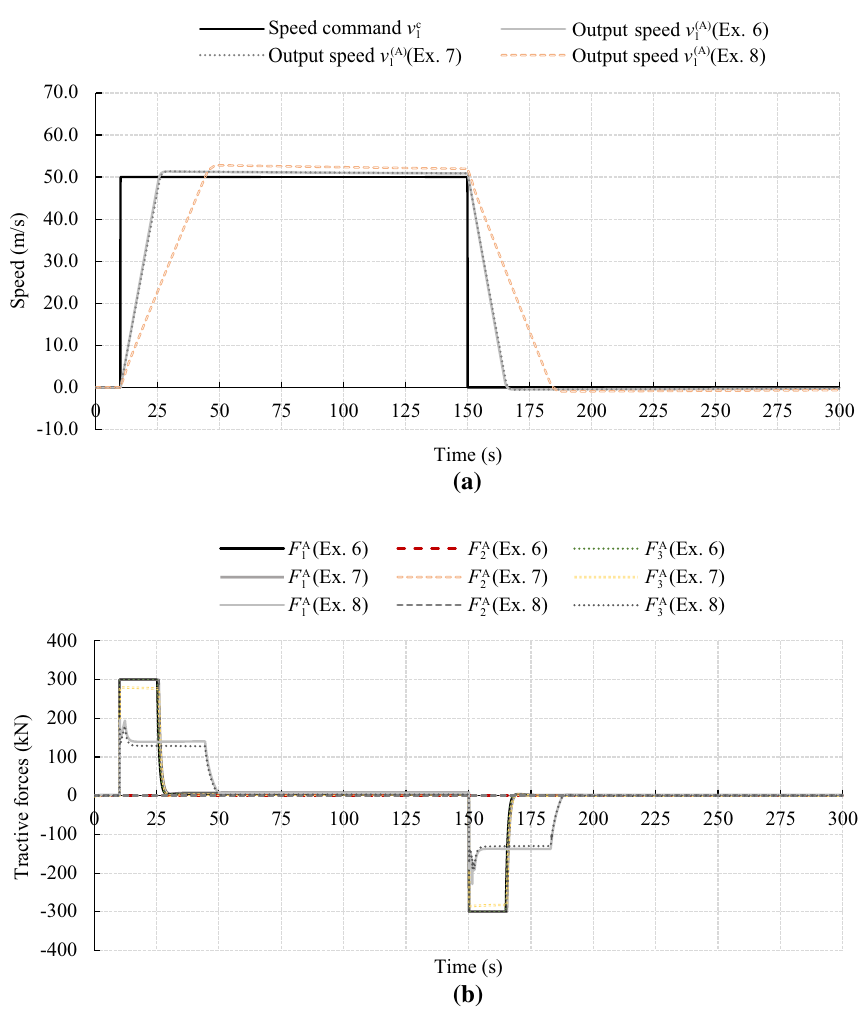
Fig. 12 Simulation results based on the LTD for model A of the push–pull MUT: a train speed _ x 1 vs. time; b tractive forces F A 6, passive vibration damping is only